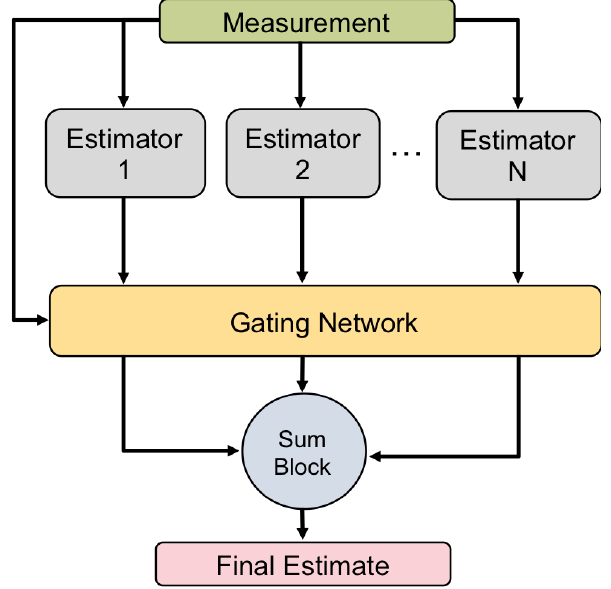
Figure 2. Multiple Model Estimation (MME) filter bank with gating